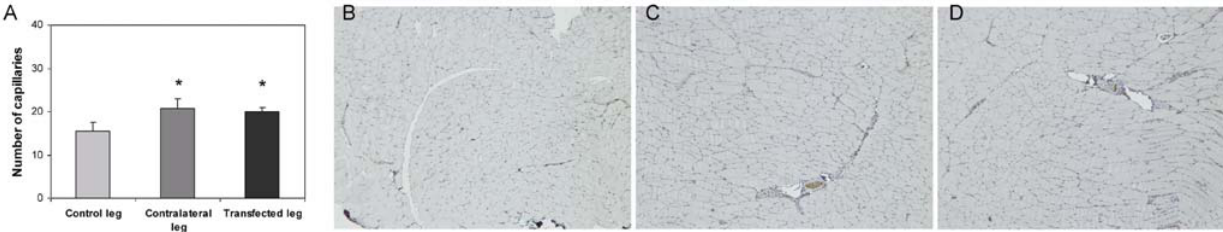
Figure 3. EPO increases vascularisation in the transfected muscle. Histological sections were performed from muscles excised 5 weeks after DNA electrotransfer and stained with CD31. A) Mean number of capillaries per muscle section (n=8, mean 6 SEM), and representative pictures of histological sections of B) control muscle, C) contra lateral muscle, and D) EPO transfected muscle. Statistical significance was tested by Student’s t- test with Bonferroni corrections for multiple testing. * indicates significance at p ,